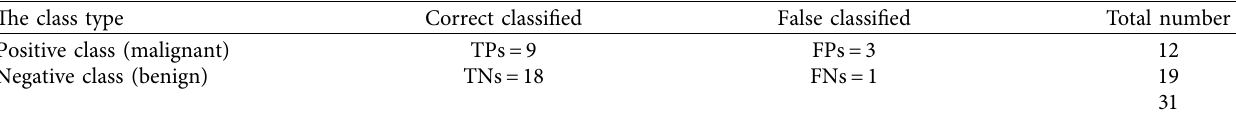
Table 6: The confusion matrix of the second SVM classifier, in the testing of malignant and